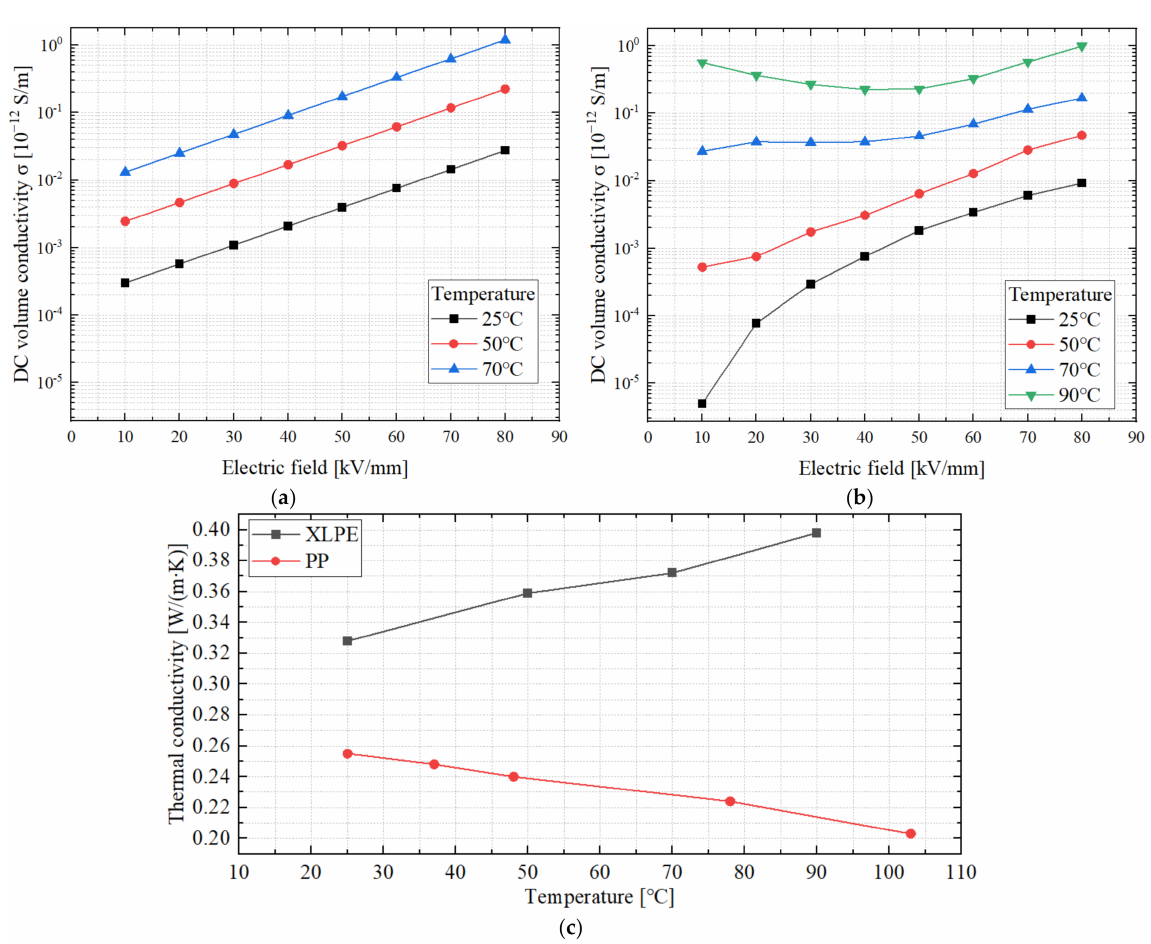
Figure 4. ( a ) DC volume conductivity of XLPE material; ( b ) DC volume conductivity of PP material; ( c ) Thermal conductivity of insulation versus